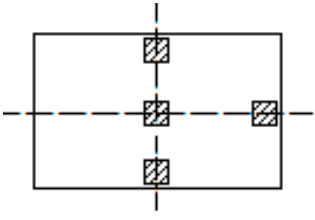
Figure 2. The sample position in the ingot.